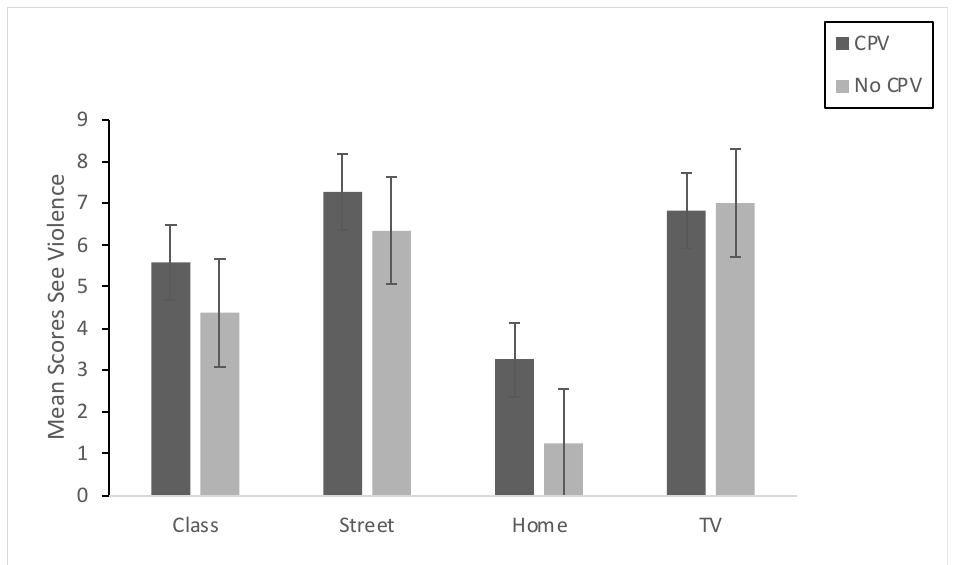
Figure 1. Means and Std. Error for indirect exposure to violence (Seeing violence in class, on the street, at home, and on TV) of the group that reported having committed CPV (CPV) and of the group that reported not having done so (No CPV).